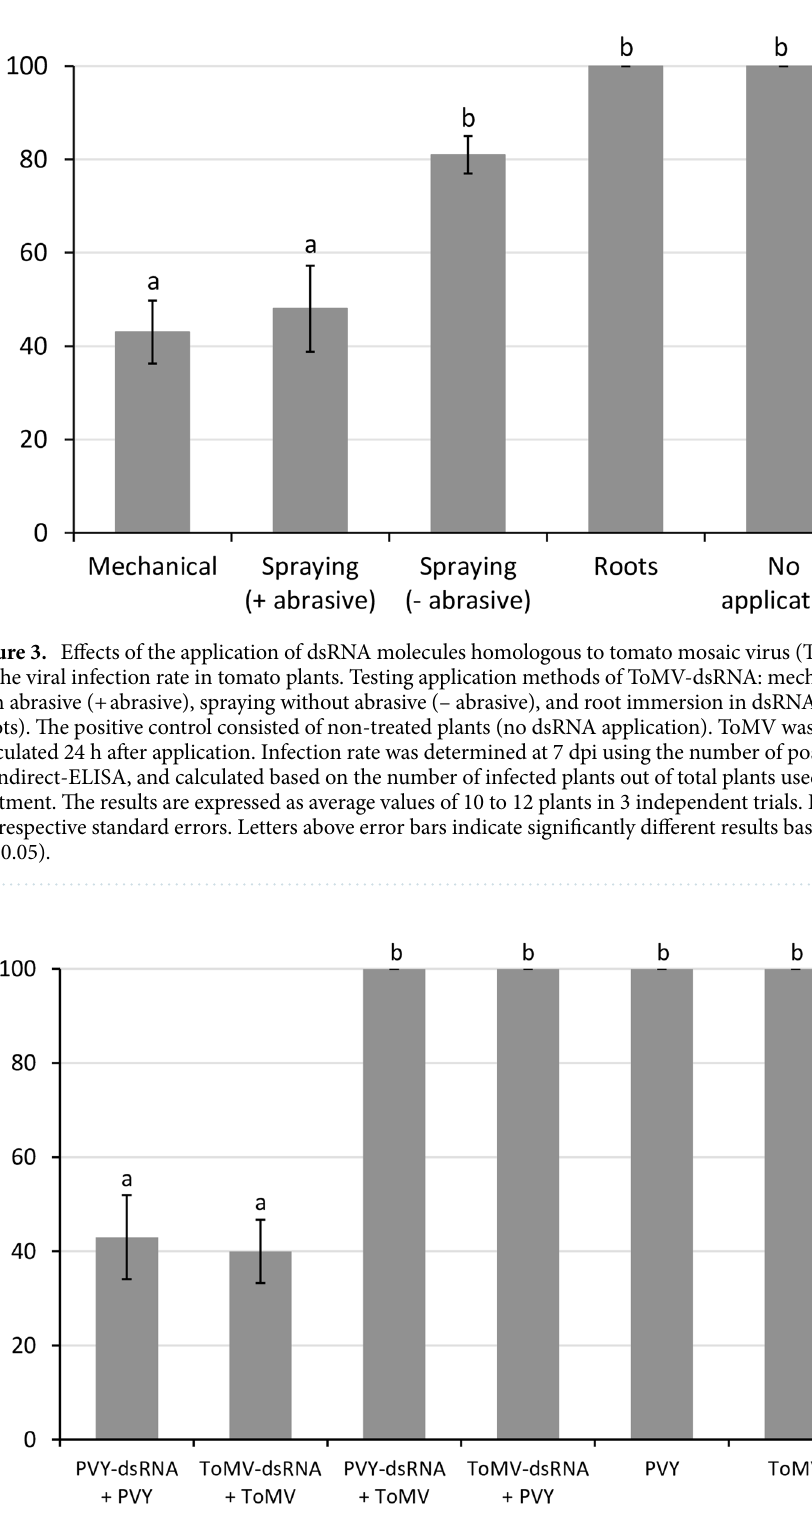
Figure 4. Effects of the application of dsRNA molecules homologous to tomato mosaic virus (ToMV) and potato virus Y (PVY) sequences on the viral infection rate in tomato plants. Testing specificity of protection by PVY-dsRNA and ToMV-dsRNA application. The dsRNA was mechanically applied and then PVY or ToMV was inoculated. Infection rate was determined at 7- and 10-dpi for ToMV and PVY, respectively, using the number of positive plants by indirect-ELISA, and calculated based on the number of infected plants out of total plants used in each treatment. The results are expressed as average values of 10 to 12 plants in 3 independent trials. Bars represent the respective standard errors. Letters above the error bars indicate significantly different results based on Tukey test ( p <